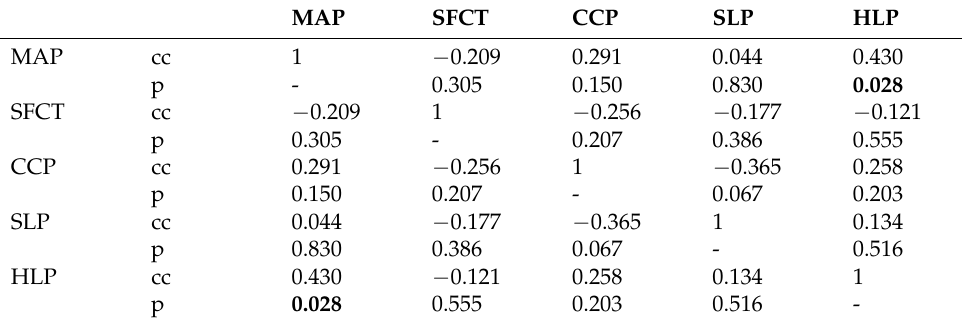
Table 3. Correlation analysis of the control group.